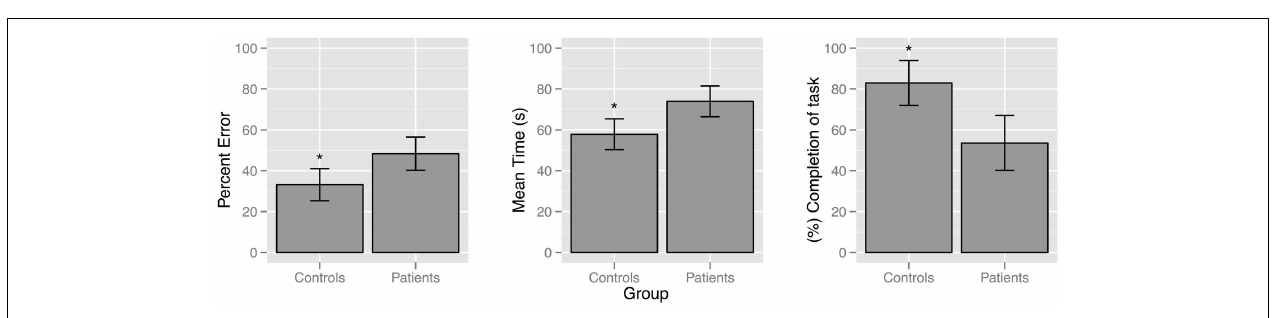
FIGURE 1 | Bar plot demonstrating differences between patient and control groups for the behavioral navigation variables: percent error [ F (1,41) = 9.64, p = 0.003]; mean time [ F (1,41) = 12.28, p = 0.001]; and accuracy [ F (1,41) = 15.47, p = 0.000] .